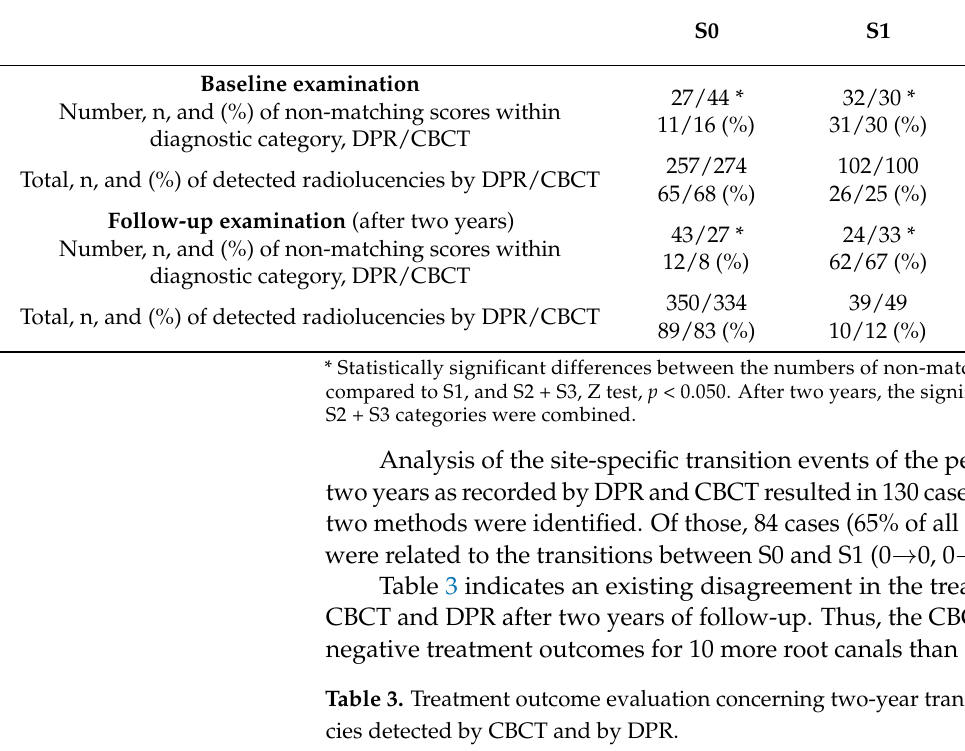
Table 2. Site-specific comparison of the non-matching scores of periapical radiolucencies detected by DPR and CBCT, concerning the severity of periapical radiolucency, at baseline and after two years. Diagnostic Categories of Periapical Radiolucency